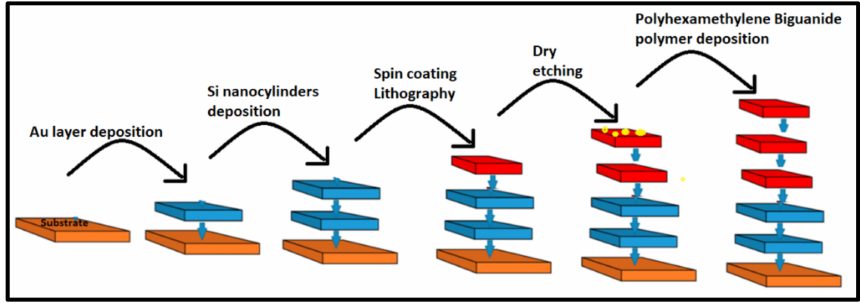
Figure 10. Sequence of fabrication steps involved in CO 2 gas